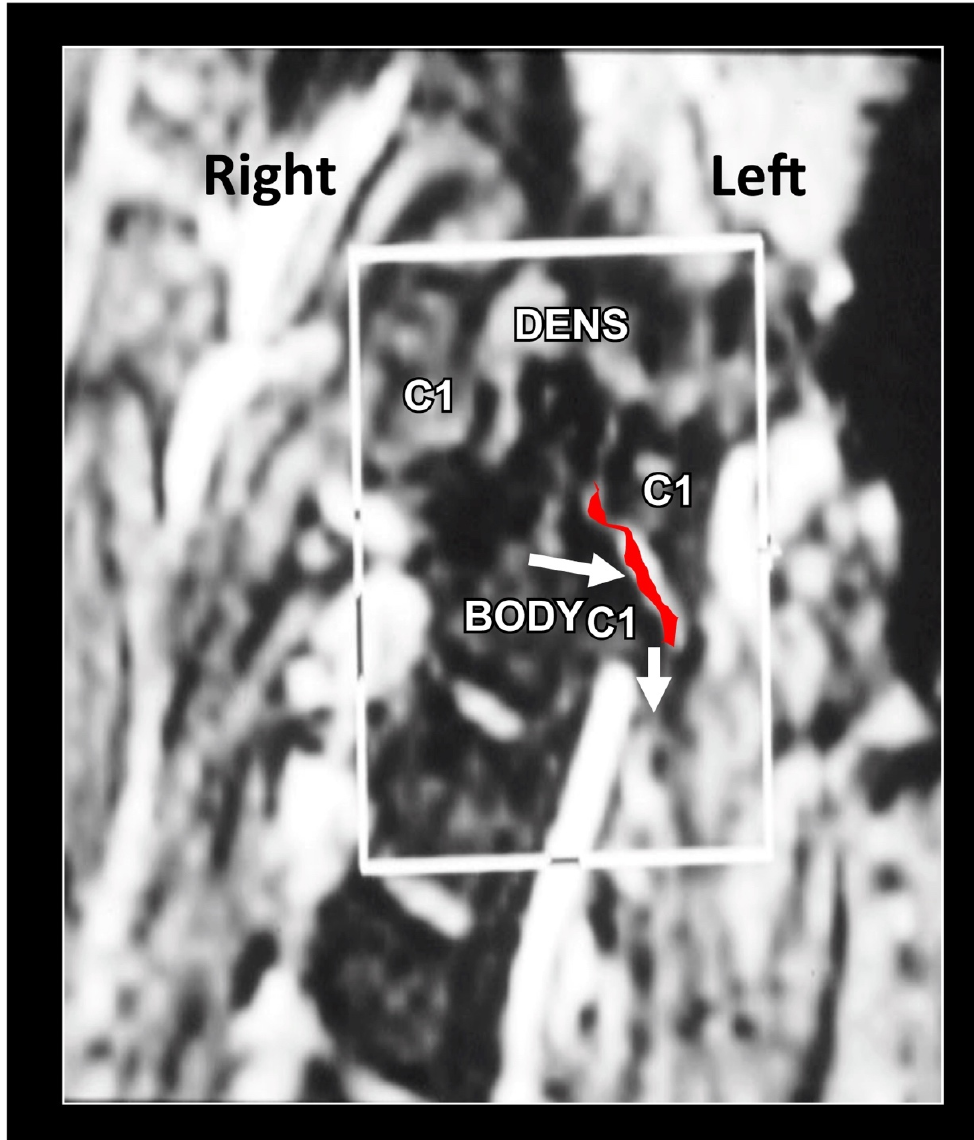
Figure 19. Atlas - axis gapping. Left coronal, dynamic magnetic resonance imaging (MRI), showing the lateral gapping of the left facet joint between the atlas and axis , during lateral cranial rotation (side bending) restriction. The lack of rotational component of the axis during lateral rotation of the cranium to the same side induces a dysfunctional pattern of cranial rotation. When the axis attempts to rotate towards one side, the superior lateral facet joint of axis drops down on the same side of the lateral rotation of the cranium, opening the gap between the lateral mass of the axis below the atlas . The lateral evaluation of the axis is painful on the restricted side of the lateral movement. The axis cannot rotate to that side and descends below the atlas causing capsular distension of the atlanto-axial joint. The MRI facilitates the understanding of the dysfunction to plan the treatment process and left rotation of the axis on the C3 vertebra. During treatment, it is important to maintain proportional rotational patterns of movement between atlas and axis